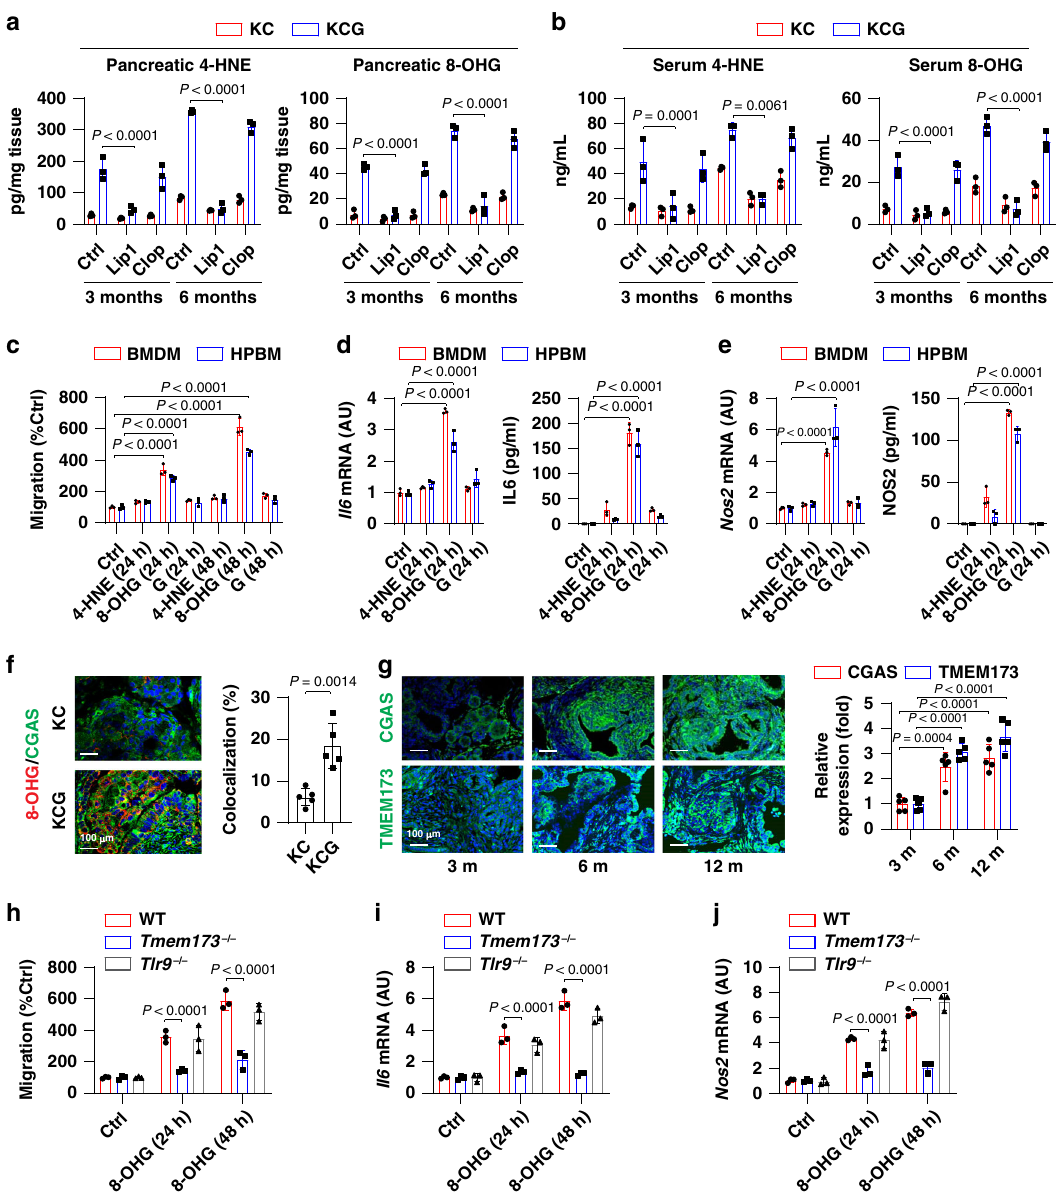
Fig. 4 8-OHG induces macrophage migration and activity. a , b Levels of 4-HNE or 8-OHG in the pancreas ( a ) or serum ( b ) in Pdx1-Cre;K-Ras G12D/ +